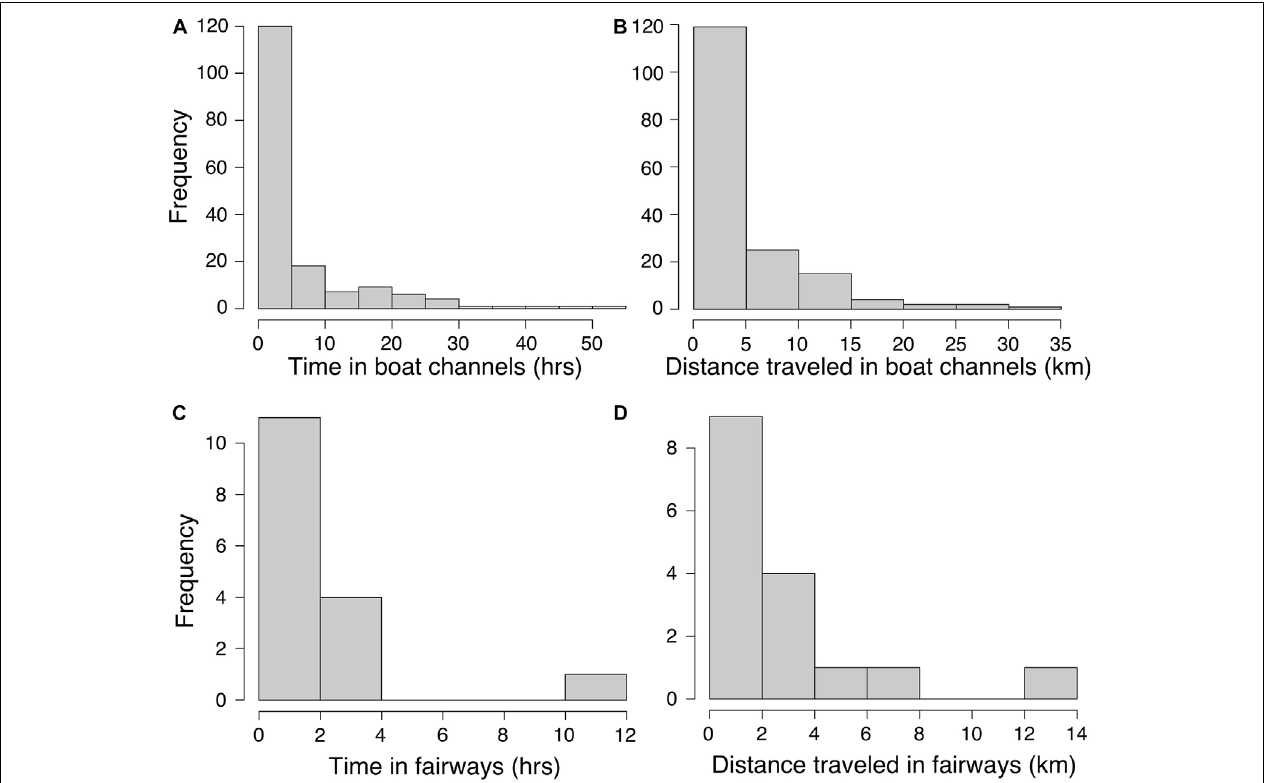
FIGURE 5 | Histograms of continuous time durations that manatees spent in 130 and 300 m boat channels (A) and fairways (C) and associated distances traveled in the 130 and 300 m boat channels (B) and fairways (D)